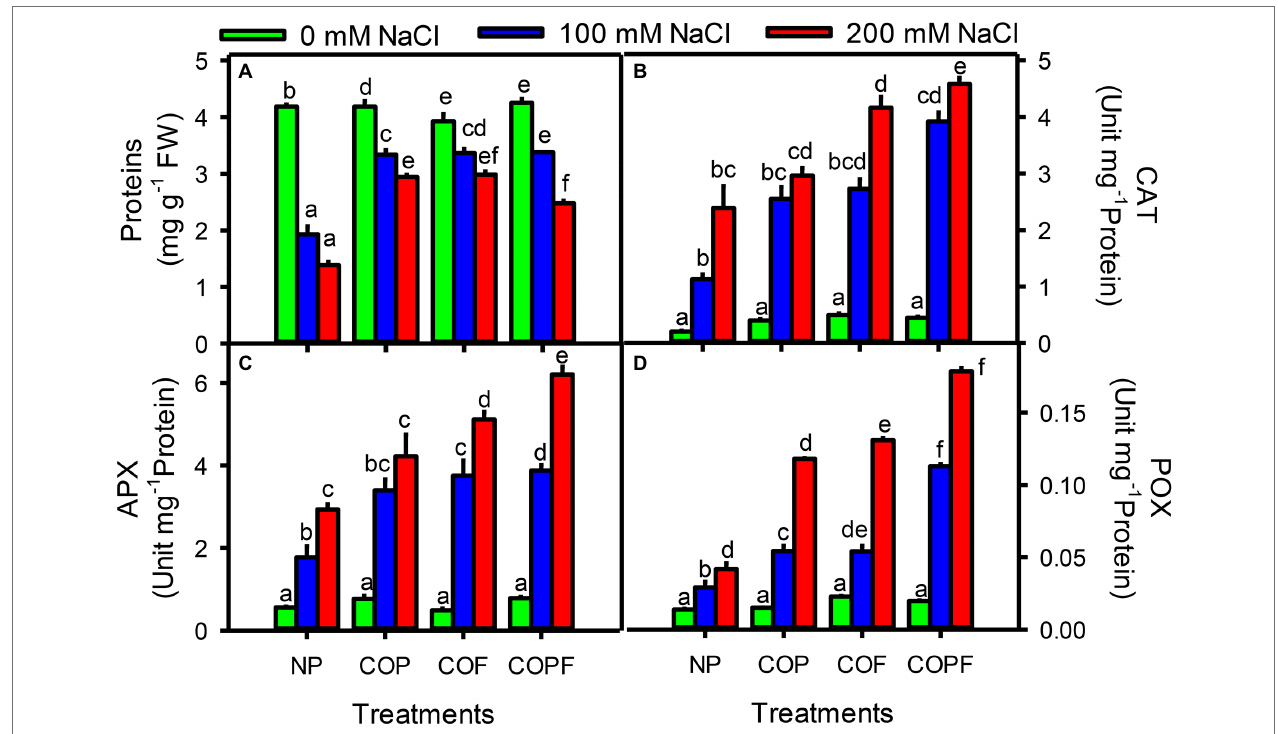
FIGURE 6 | Effect of salinity and coumarin applications on protein contents and antioxidant enzymes activities. Protein (A) , Catalase (B) , Ascorbate Peroxidase (C) and Guaicol peroxidase (D) . Plants were treated with 0 mg L − 1 coumarin (NP), 100 mg L − 1 coumarin as seed priming (COP), 100 mg L − 1 coumarin as foliar application (COF) and combined treatment (COPF), under 0, 100 and 200 mM NaCl. Values are represented as means ±SE ( n = 3). Different letters represent significant differences ( p < 0.05) by Tukey’s HSD